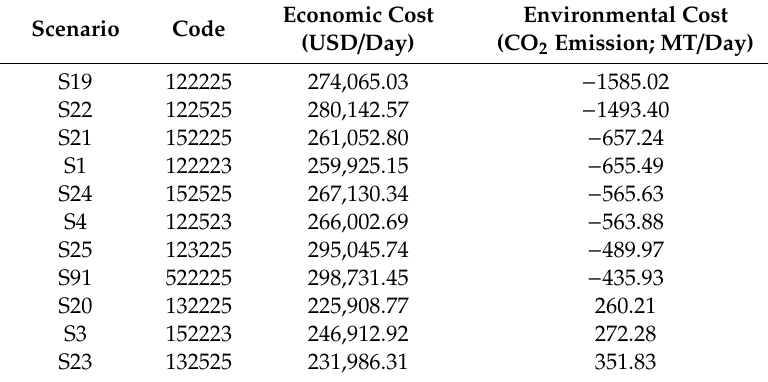
Table 7. Acceptable scenarios for initial decision